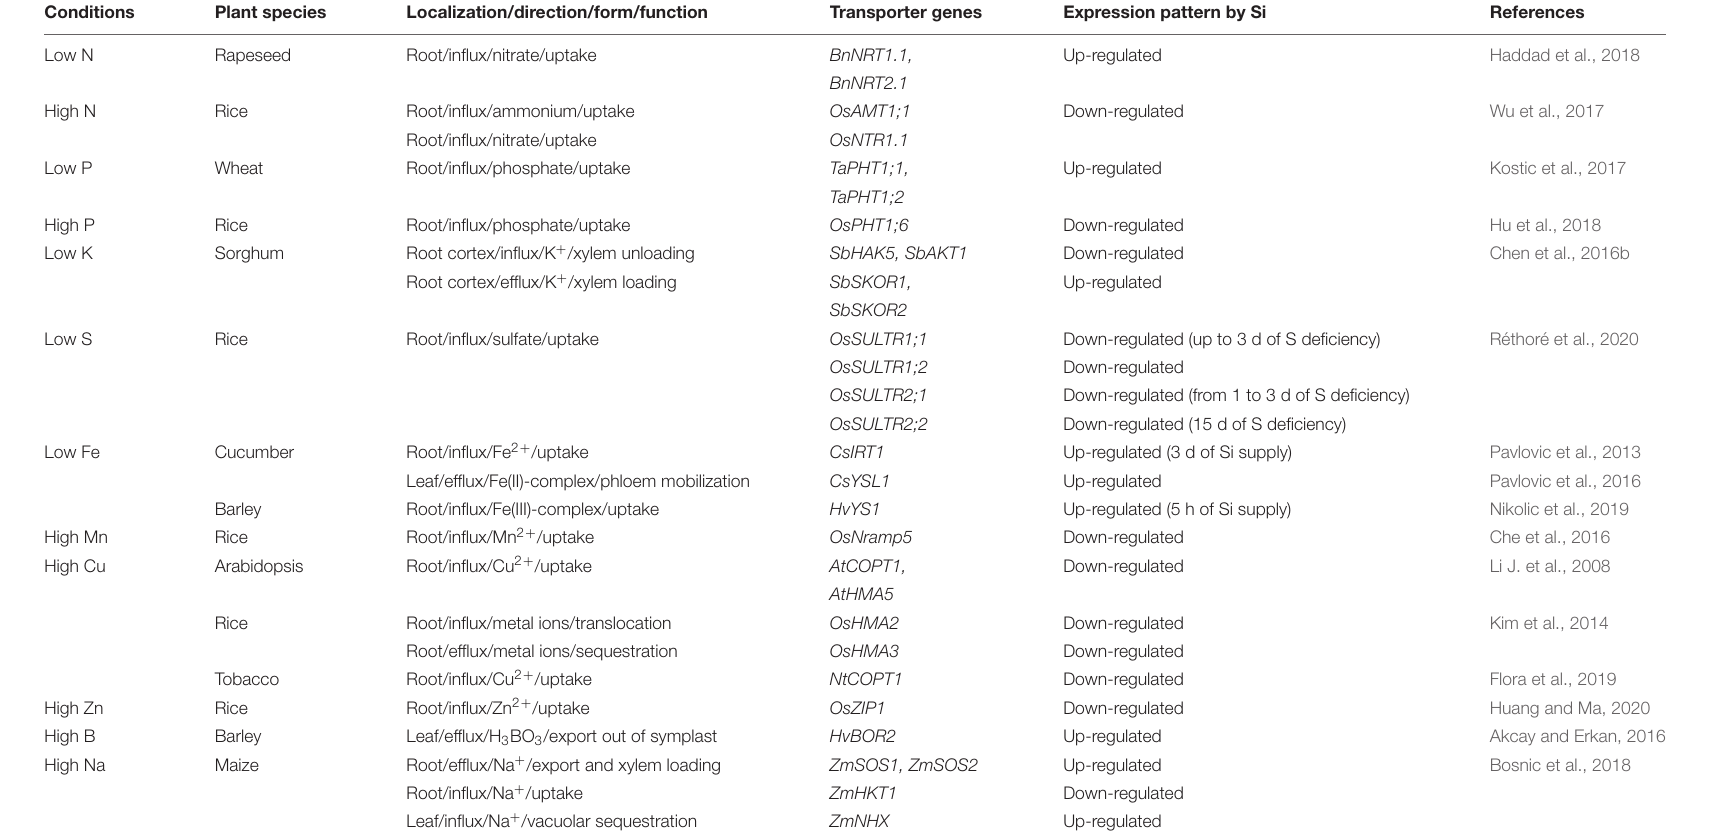
TABLE 1 | Evidence for Si-mediated expression of genes encoding transporters for essential and beneficial elements in plants.